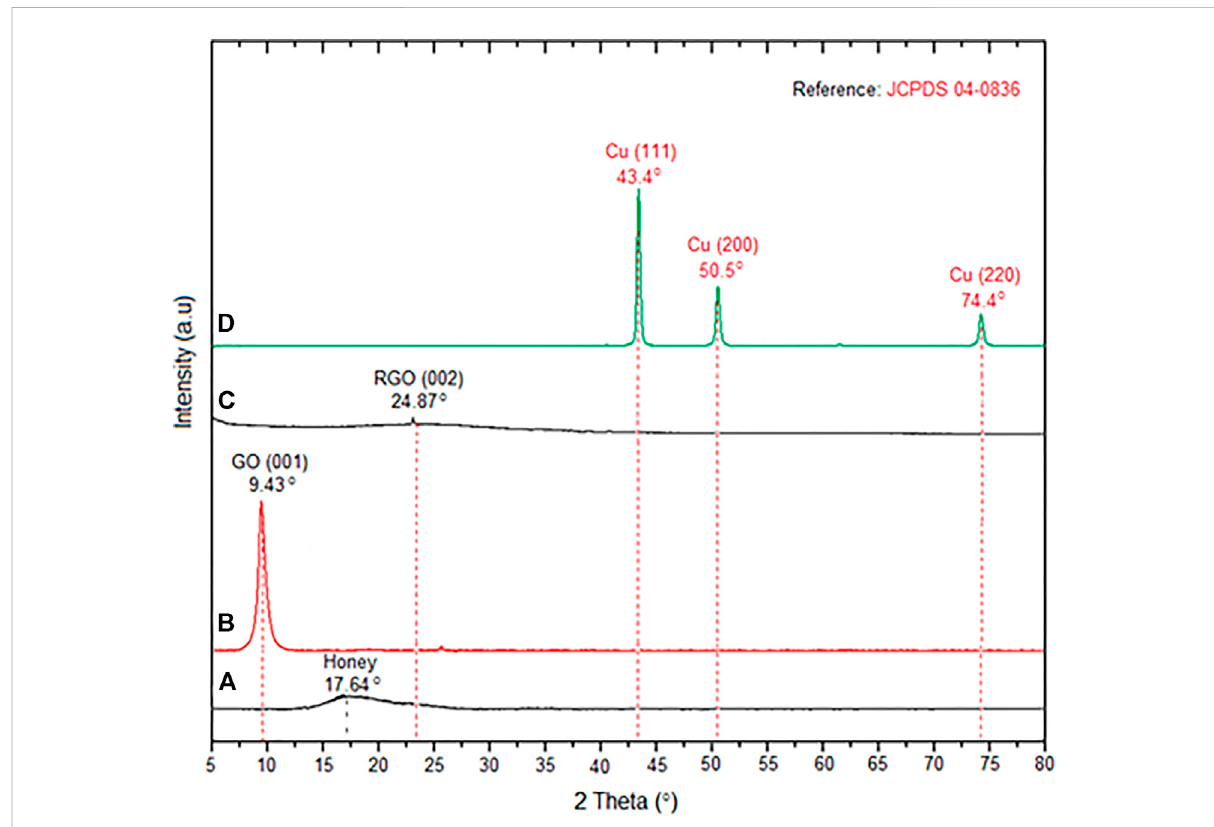
FIGURE 2 XRD patterns of (A) honey, (B) GO, (C) RGO, and (D) H/Cu/RGO